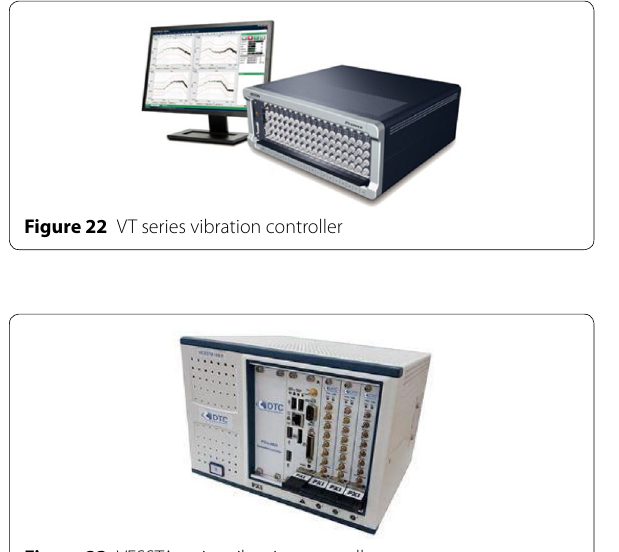
Figure 23 VESSTA series vibration